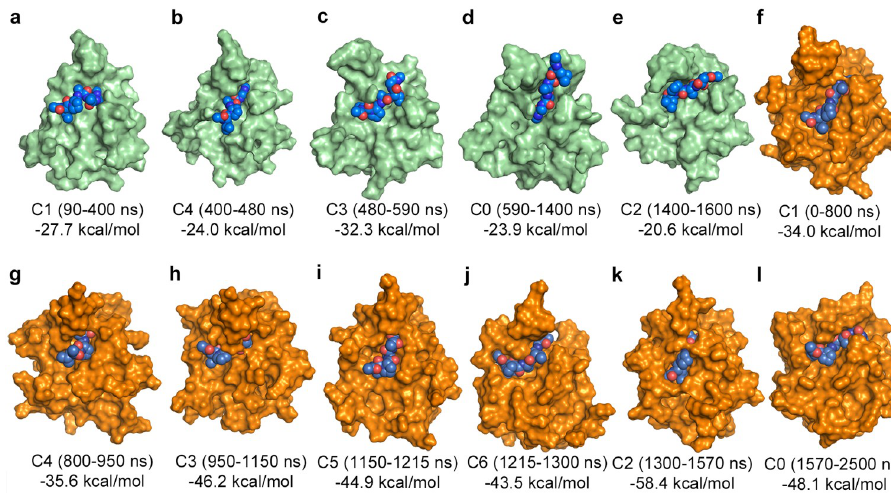
Fig 4. Structures and corresponding Δ G bind values of the sorting signal for the final bound conformations after 5ns of equilibration. Results for the representative structures chosen for the molecular docking and MMGBSA calculations from the SrtA-noCa (a-e, green) and the SrtA-Ca (f-l, orange) simulations. The receptors are shown in surface, and the sorting signals in sphere